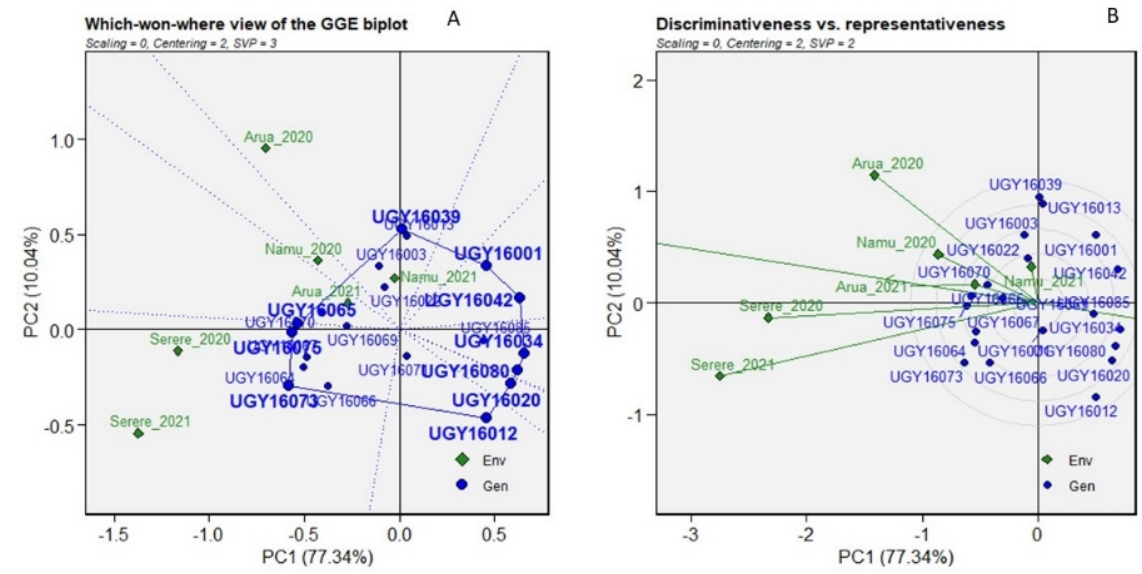
Figure 5. GGE scatterplot based on symmetrical scaling for ( A ) the “ which − won − where ” pattern and ( B ) the discriminating power and representativeness of test environments, involving the 20 yam genotypes evaluated for yam mosaic virus in six environments.